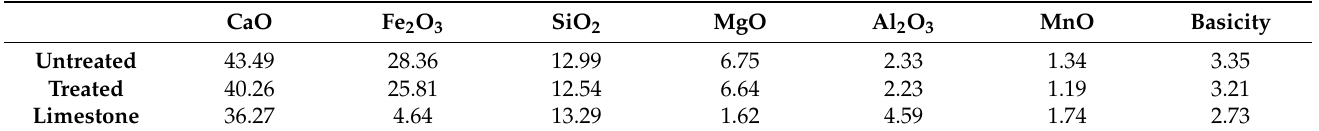
Table 8. Comparison of chemical composition and basicity of steel slag with limestone (Wt.%).